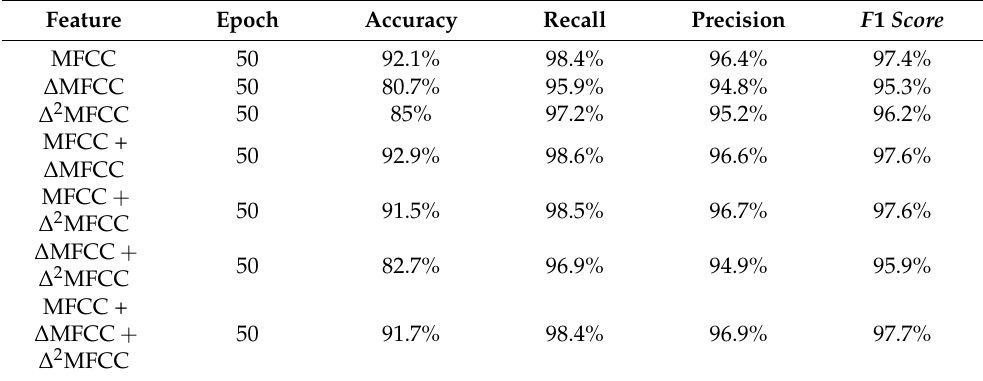
Table 4. Recognition results of DenseNet-121 for feature parameters of different